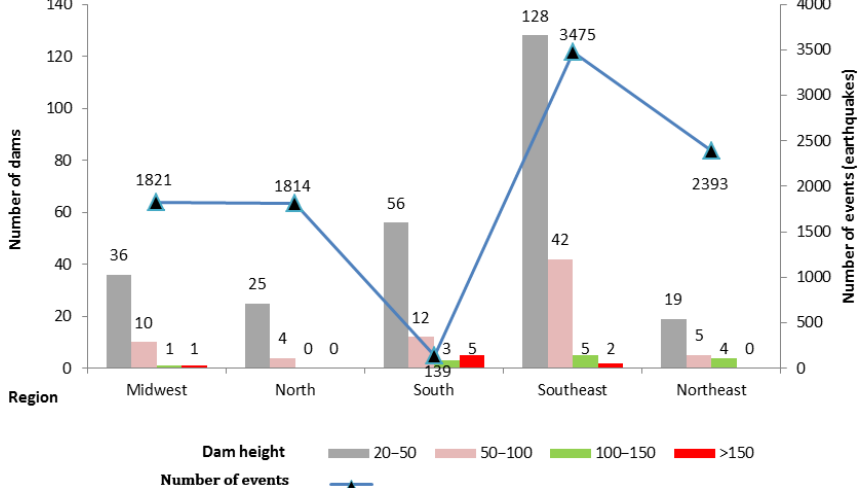
Figure 7. Graph showing the earthquakes, dams, and regions of the country. The southeastern region concentrates the highest and the most dams in the